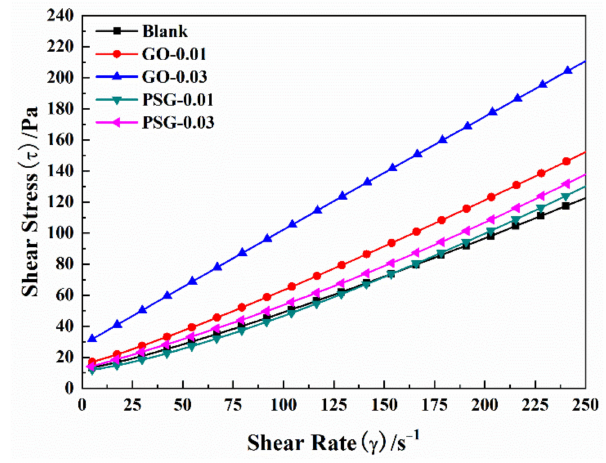
Figure 9. Diagram of H–B model-fitting